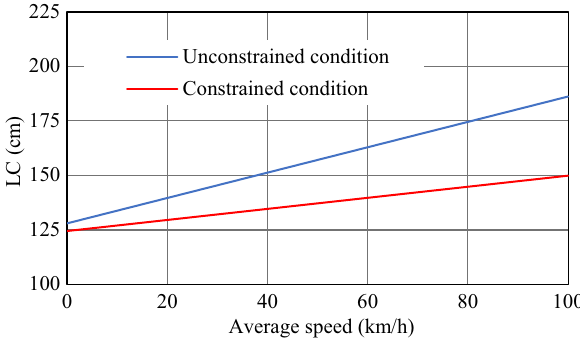
Fig. 12 Comparison of regression equations of LC-average speed relationship of car–car pair in constrained and unconstrained conditions